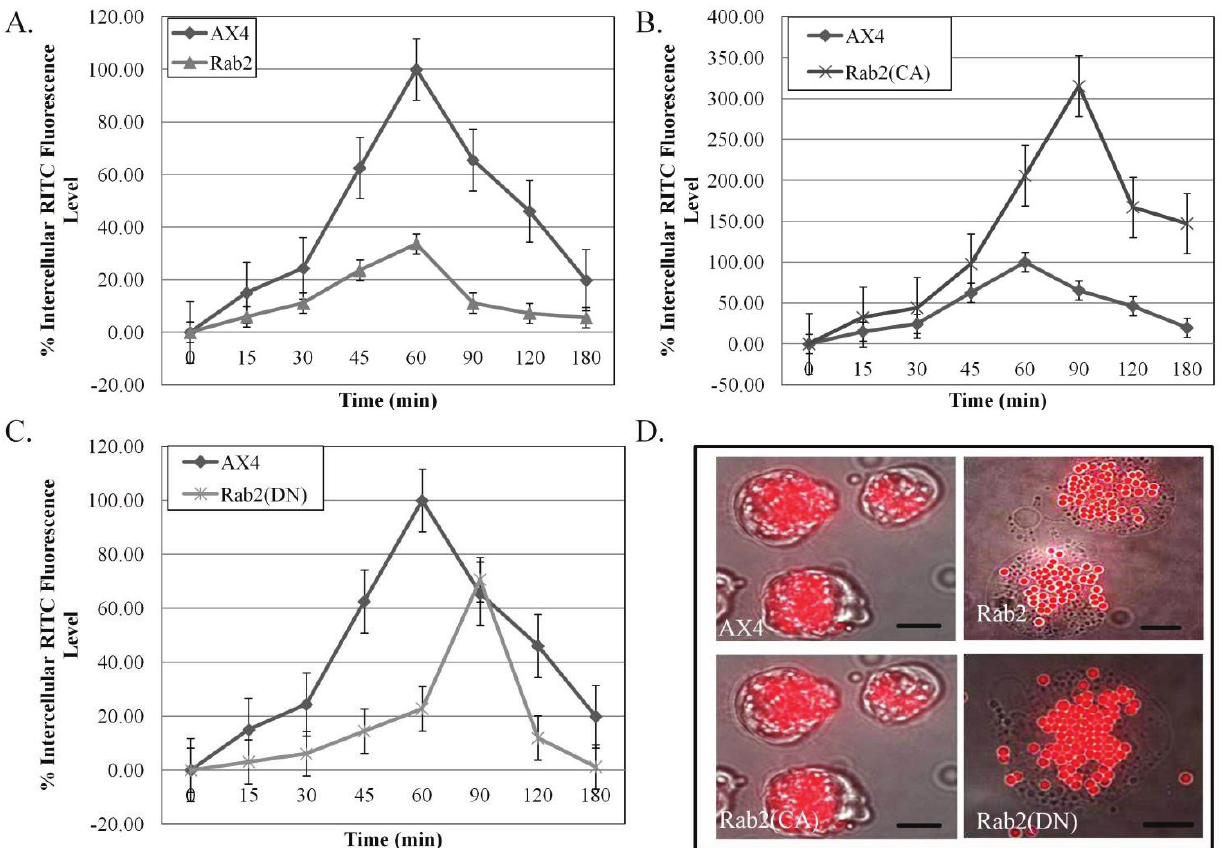
Figure 1. Phagocytosis is altered in DdRab2 over-expressing and DdRab2(CA) cell lines. ( A – C ) Graphical representation with standard error of the internalization of latex beads to quantify phagocytosis over 180 min showing significant differences ( p > 0.05) in internal fluorescence in the Rab2 ( ▲ ) and Rab2(CA) (×) cell lines over the AX4 (♦) parent strain. Data is presented as the average of three individual experiments with relative fluorescence to AX4 which is being considered 100% at 60 min. ( A ) The Rab2 over-expressing cell line showed a significant decrease in internal fluorescence representing phagocytosis compared to the WT-AX4 cell line; ( B ) The Rab2(CA) expressing cell line showed a significant increase in internal fluorescence representing phagocytosis compared to WT-AX4 cells. Rab2(CA) expressing cells interestingly showed a decrease in the rate of phagocytosis compared to WT-AX4 cells, not reaching their maximum internalization until the 90 min time point compared to the WT-AX4 cells reaching maximum internalization at 60 min; ( C ) Rab2(DN) expressing cell lines showed no significant difference in the internal fluorescence representing phagocytosis as compared to AX4 cells, however, the rate of phagocytosis in this cell line was decreased reaching maximum phagocytosis at 90 min compared to the WT-AX4 cells reaching maximum phagocytosis at 60 min; ( D ) Overlaid images of bright field with visualization of red latex beads in AX4, Rab2 over-expressing, Rab2(CA), and Rab2(DN) cell lines. The image shows a decrease in the amount of beads compared to the AX4 in the Rab2 over-expressing cell line, and an increase in the amount of beads in the Rab2(CA) expressing cell line confirming the amount of internal fluorescence representing phagocytosis observed in the graphical representation. Scale Bar: 5